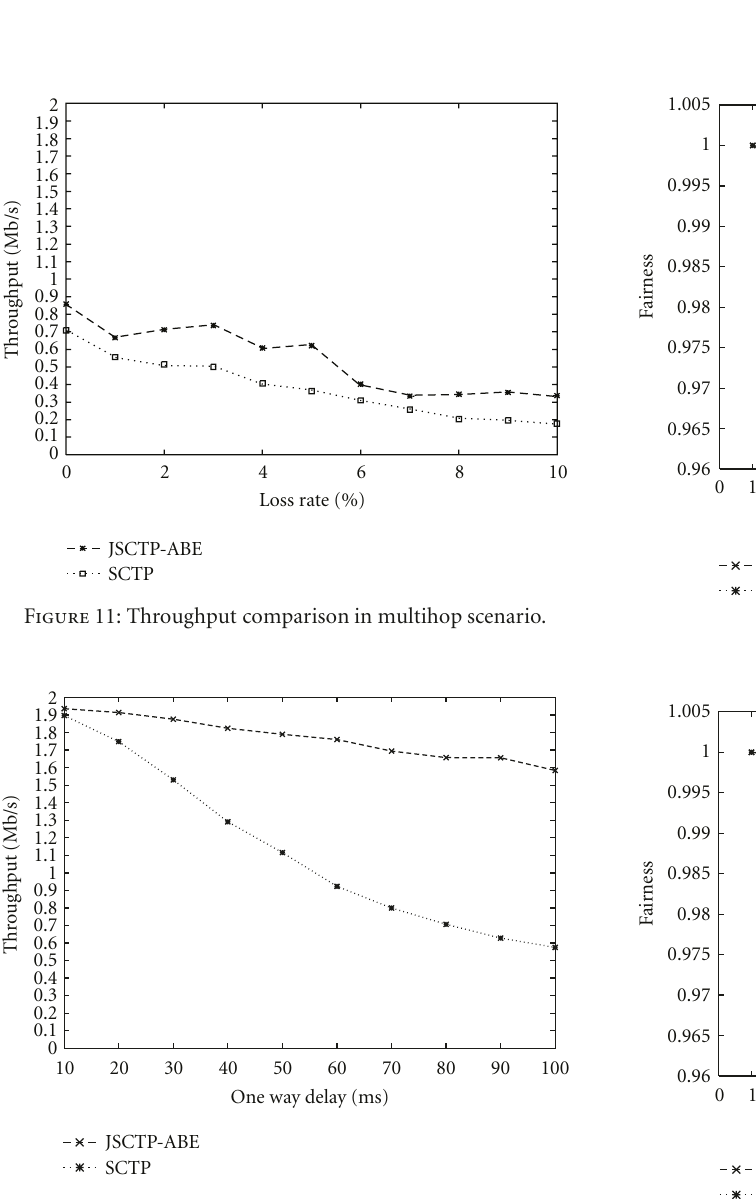
Figure 10: Multihop simulation topology.